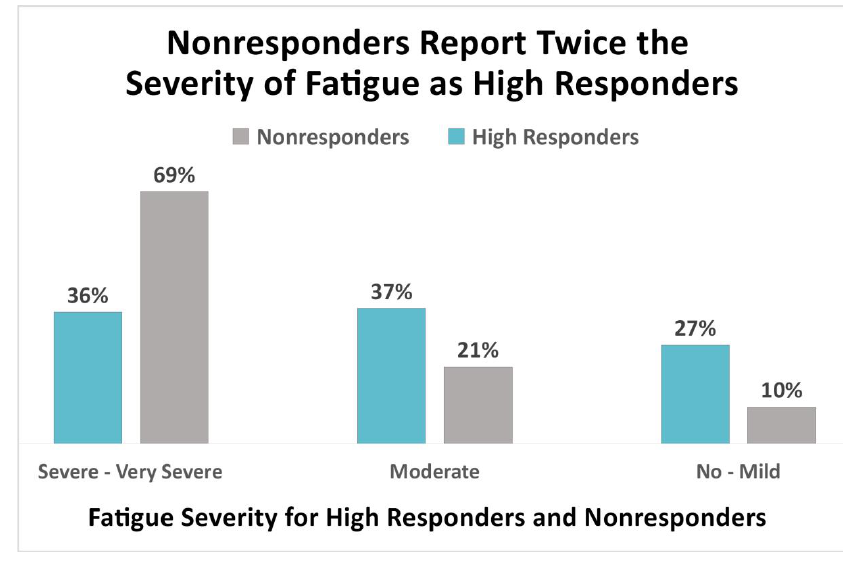
Figure 3. Severe and very severe fatigue is reported by nearly twice as many nonresponders (69%) compared to high responders (36%).